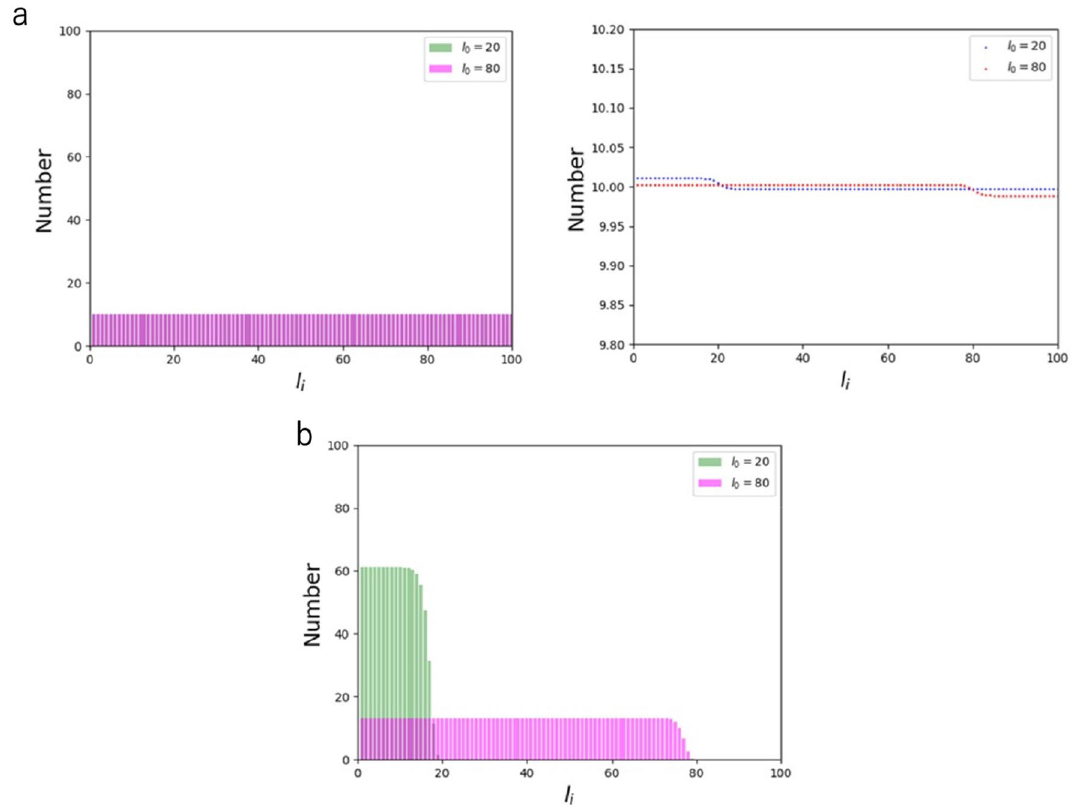
Figure 5. Length distribution of AFs comprising of N = 1000 monomers with l 0 = 20 (green) and l 0 = 80 (pink) at f 0 = 10 –4 ( a ) and f 0 = 10 0 ( b ). For visual clarity, point plots are also shown on the right for the case of a with magnified vertical